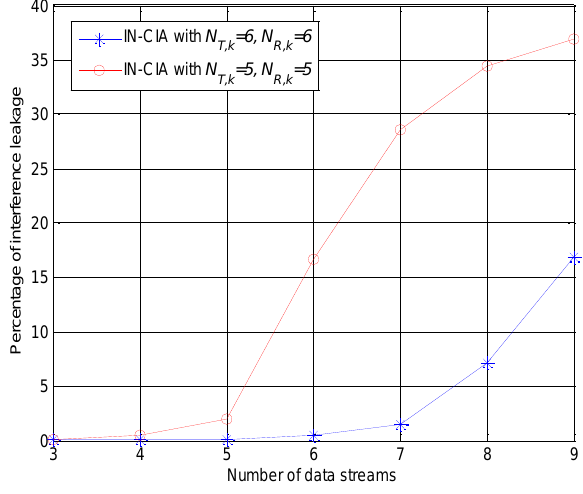
Figure 5. Percentage of interference leakage versus the number of data streams.